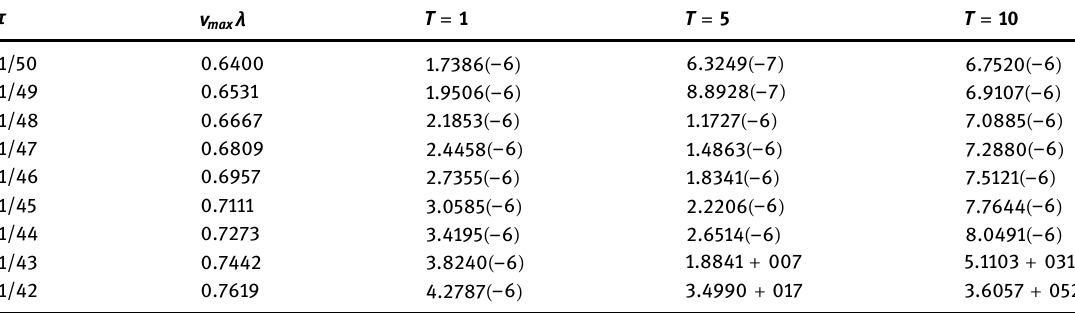
Table 4: The L ∞ error with = / h 1 32 by the HOC - LOD scheme for di ff erent T and τ for Example 1